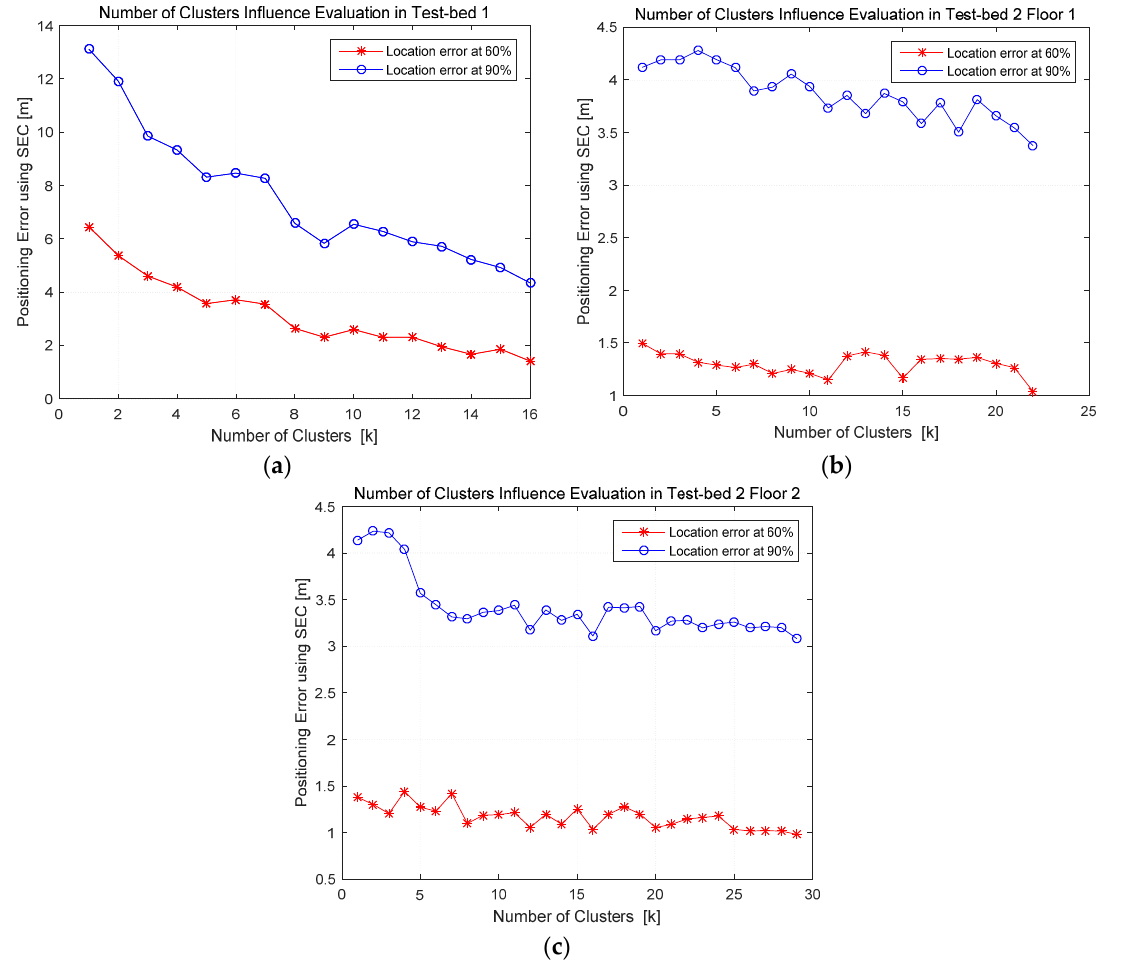
Figure 13. Number of clusters influence evaluation and comparison in Test-bed 1 and Test-bed 2 utilizing SEC clustering under MWKNN matching algorithm: ( a ) number of clusters influence evaluation in Test-bed 1; ( b ) number of clusters influence evaluation in Test-bed 2 Floor 1; and ( c ) number of clusters influence evaluation in Test-bed 2 Floor 2.